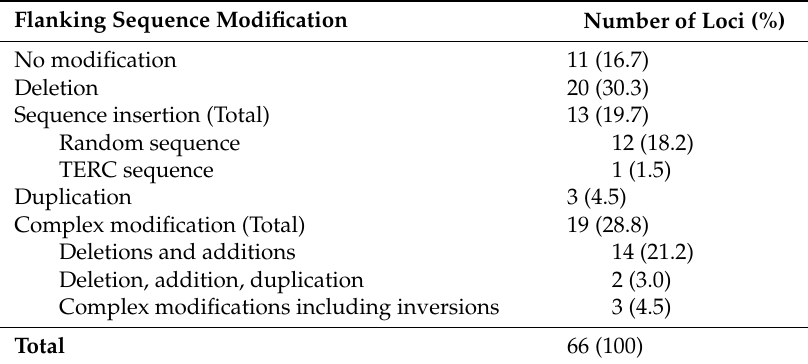
Table 5. Flanking sequence modification.